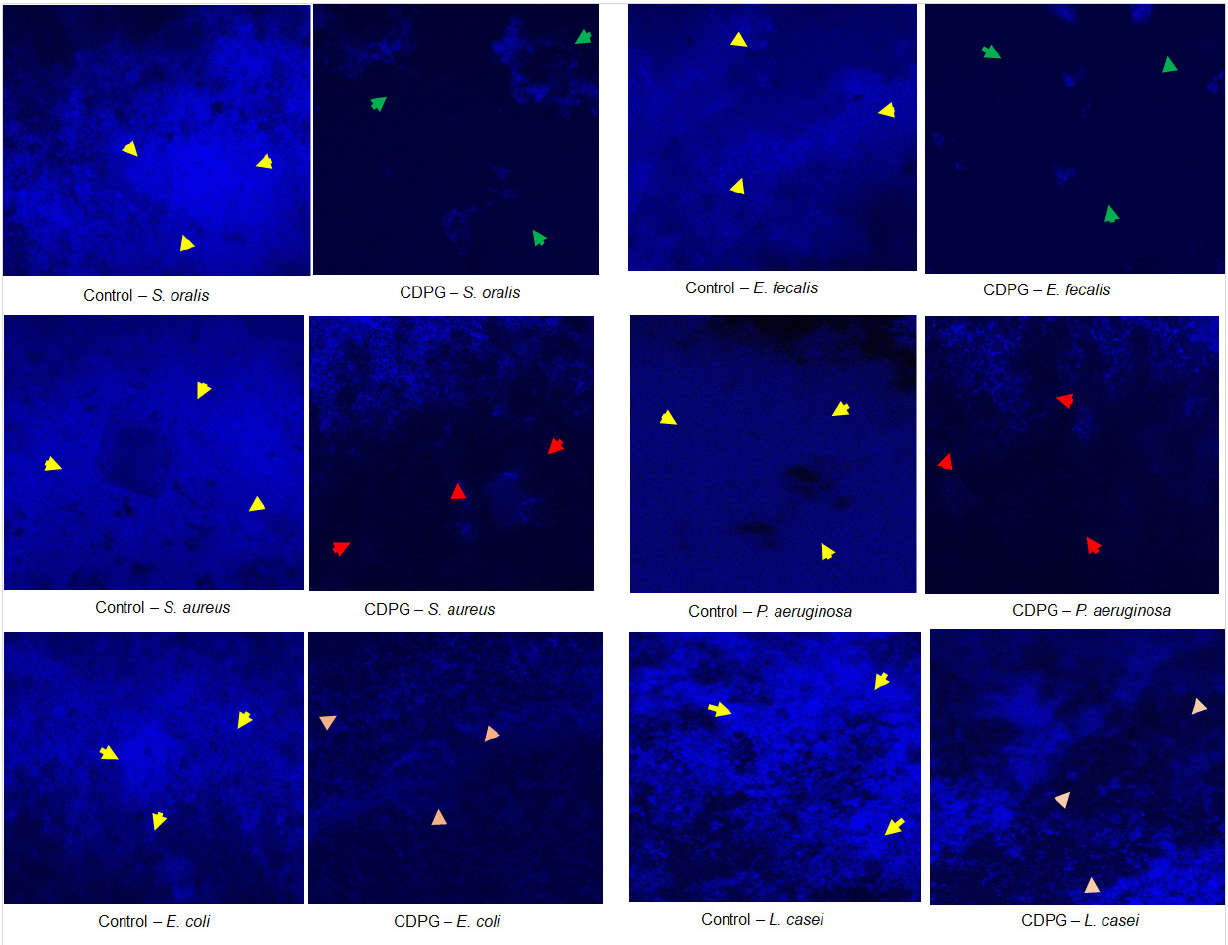
Figure 4. CLSM images showing the disruption of biofilm, produced by different bacterial strains on hydroxyapatite discs, caused by 100 mg/mL CDPG in comparison to the control bacteria growing in the absence of CDPG. Yellow arrows indicate multiple layers of biofilm formed by bacteria. Green arrows indicate large areas of complete disruption of biofilm as seen with E. fecalis and S. oralis . Red arrows refer to medium-size pockets of complete disruption of biofilm as seen with S. aureus and P. aeruginosa, while orange arrows refer to small areas of complete disruption of biofilm as seen with E. coli and L. casei .